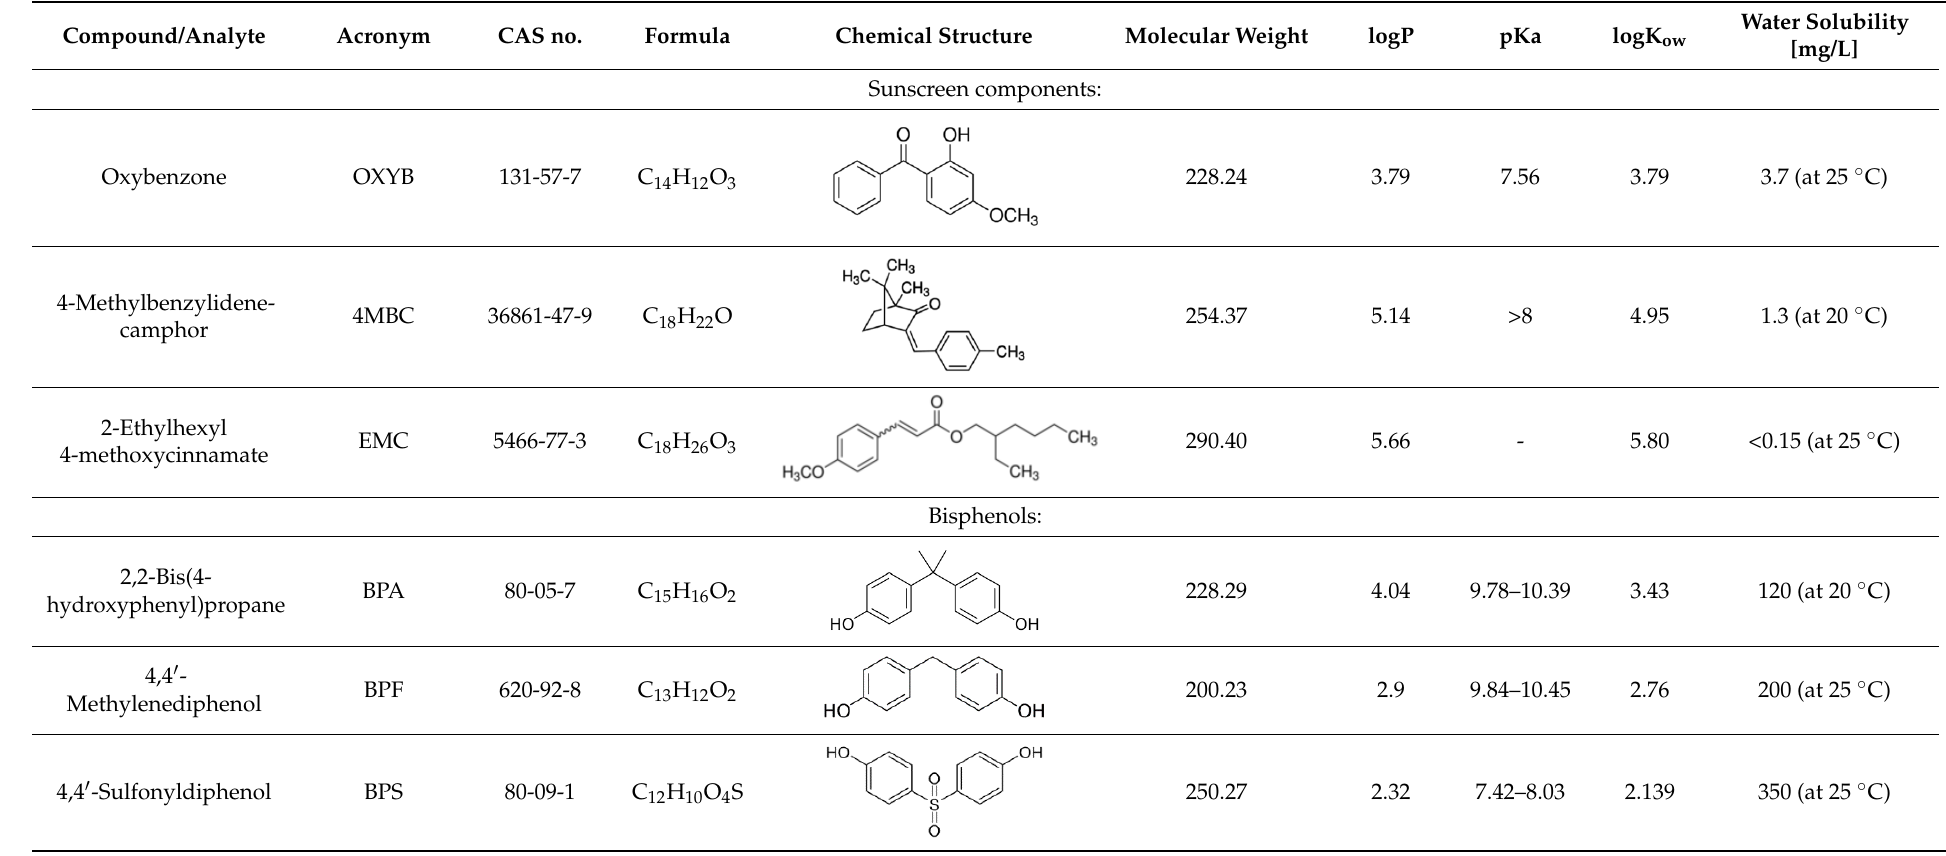
Table 2. Basic information on the UV filters and BPs studied.